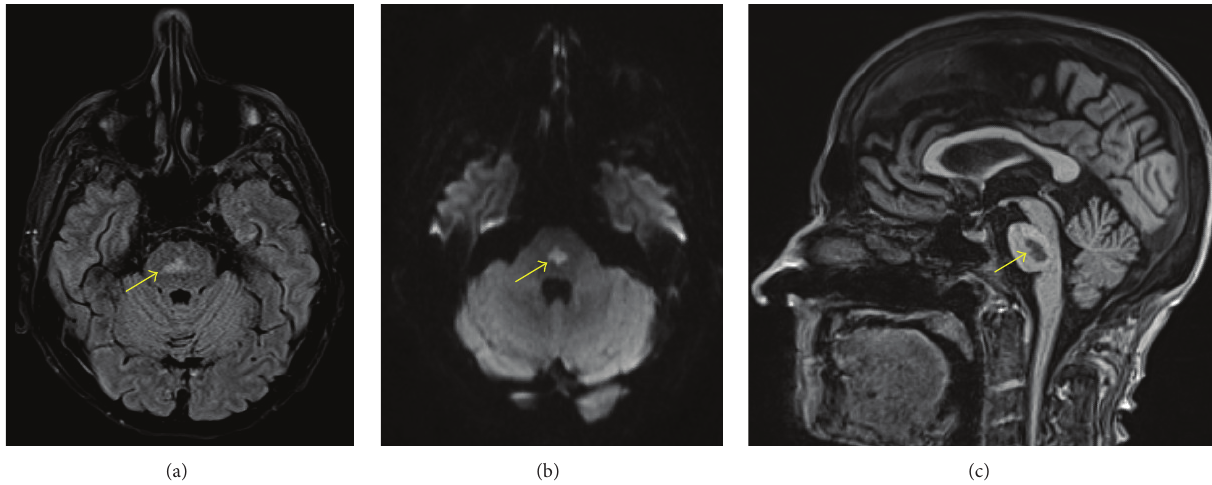
Figure 1: Brain magnetic resonance imaging shows a lesion in the central pons with imaging characteristics consistent with demyelination. The lesion is hyperintense on both (a) Fluid-Attenuated Inversion Recovery Image and (b) Diffusion-Weighted Imaging. The lesion is hypointense on (c) T1-weighted